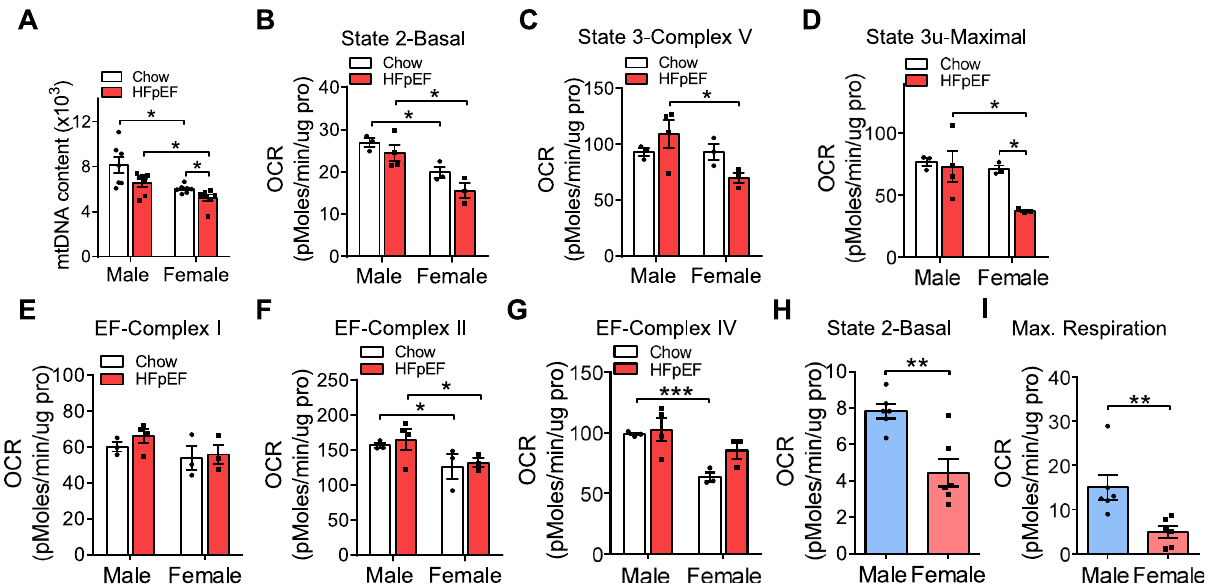
Fig. 4 Female mice exhibited reduced mitochondrial function. A Heart mtDNA content in C57BL/6J male and female mice (8 weeks old) fed with chow diet or HFD + l-NAME for 7 weeks. N = 7. p (male-chow/female-chow) = 0.011; p (male-HFpEF/female-HFpEF) = 0.015; p (female) = 0.03. B – G Oxygen consumption rates (OCR) of isolated mitochondria from C57BL/6 J male and female hearts were measured by Seahorse assay. The coupling assay measures basal respiration in presence of palmitoyl-carnitine, state 3 (ADP), and state 3 u (FCCP). The electron fl ow measures complex I (palmitoyl- carnitine), complex II (succinate), and complex IV (TMPD) respiration. Chow, n = 3; HFpEF, n = 4 (male) or 3 (female). B p (male-chow/female- chow) = 0.014; p (male-HFpEF/female-HFpEF) = 0.022. C p (male-HFpEF/female-HFpEF) = 0.046. D p (male-HFpEF/female-HFpEF) = 0.048; p